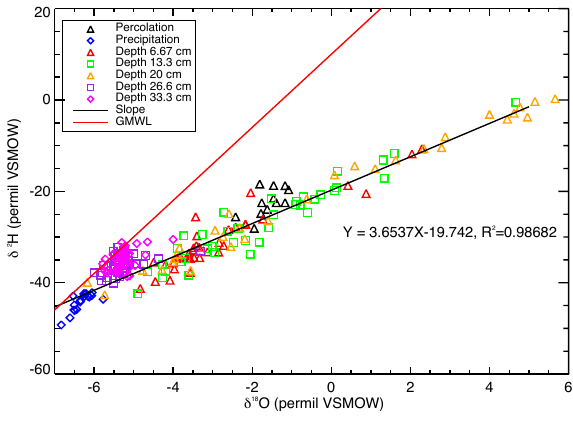
Fig. 5. Isotope measurement results plotted against